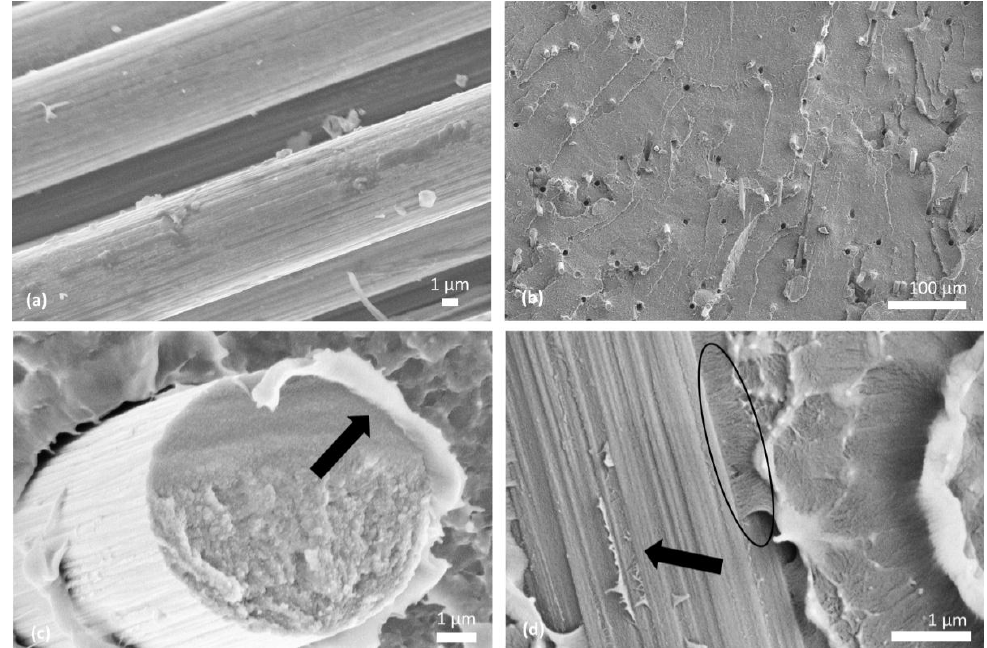
Figure 2. Morphology of ( a ) as received CF; ( b ) 5CF-PEEK at low magnification; ( c ) 20CF-PEEK at high magnification with the axial cross section of carbon fiber visible; and ( d ) 20CF-PEEK at high magnification with the longitudinal orientation of the fiber visible, via SEM.